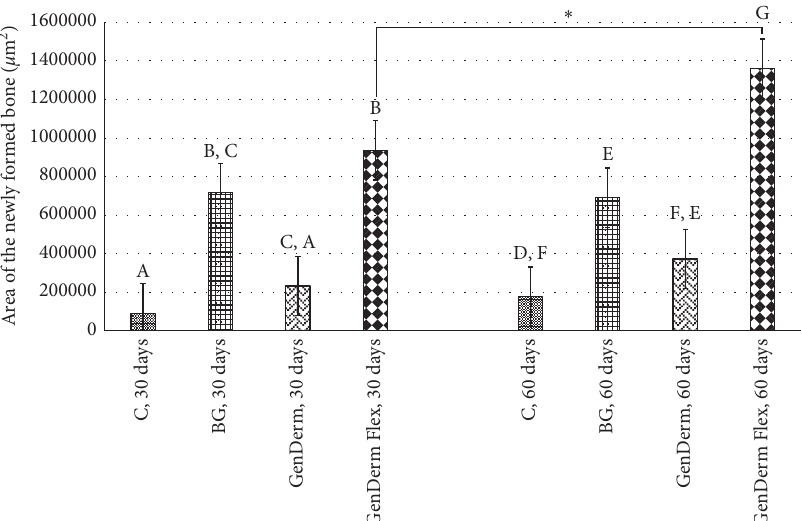
Figure 4: Area of the newly formed bone for the groups at 30 and 60 days. The character ∗ demonstrates statistical intragroup differences (GD and GDF) and the different letters demonstrate statistical intergroup differences (C, GD, GDF, and BG) with Tukey’s